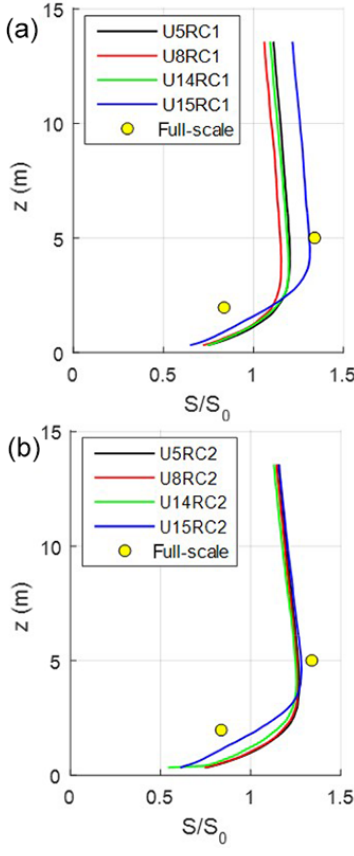
Figure 12. Vertical profiles of speed-up ratio at M6 for (a) RC1 cases and (b) RC2